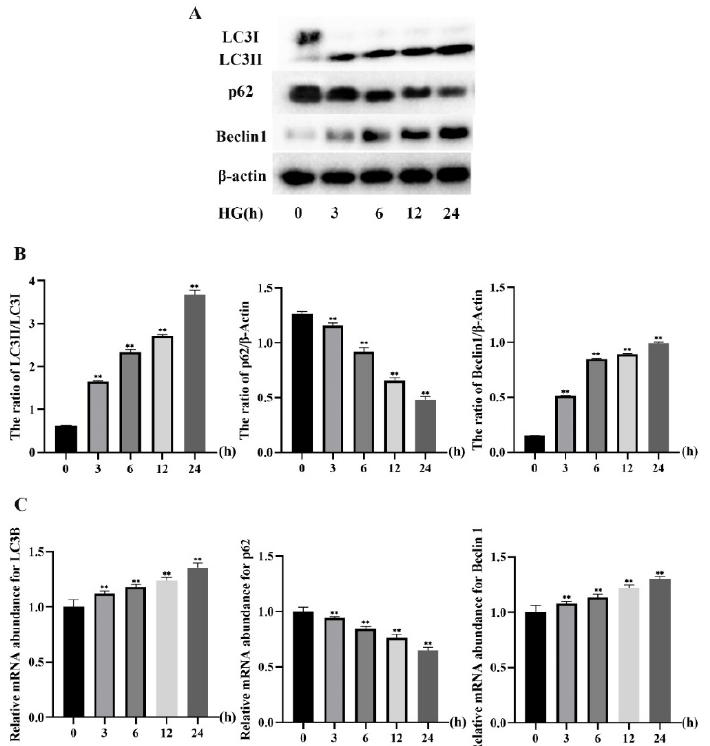
Figure 3. Effects of different treatment times of HG on autophagy in MDBK cells. MDBK cells were treated with 25.5 mM glucose for 0, 3, 6, 12, and 24 h, respectively. Western blot and qRT-PCR were used to assess protein expression, and gene expression, respectively. ( A , B ) The protein level of LC3-II/I, p62, and Beclin1; ( C ) The mRNA expression level of LC3B, p62, and Beclin1. ** p < 0.01 compared with control group.